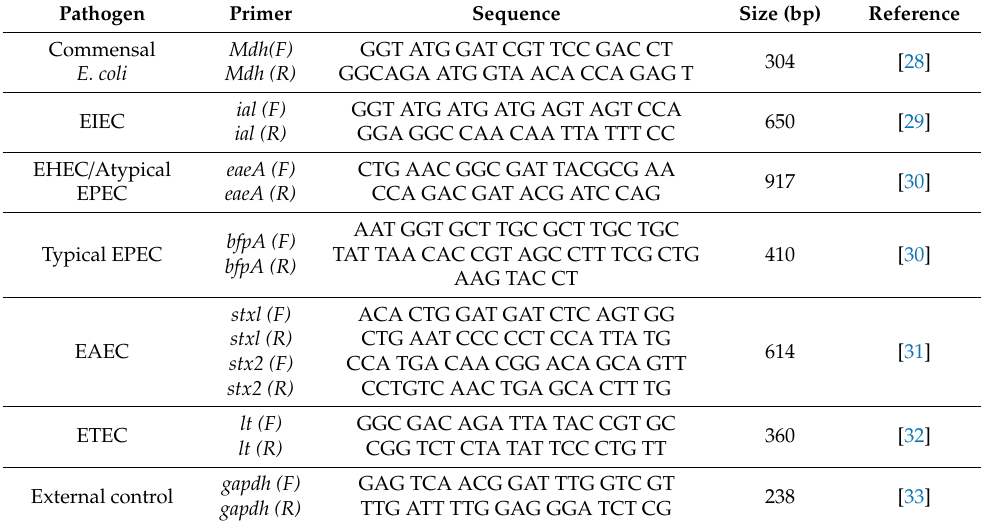
Table 1. Primers used for detection of diarrhoeagenic E. coli strains (Omar and Barnard, 2014).